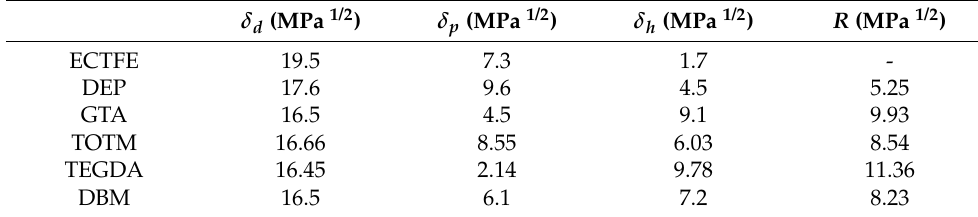
Table 2. Solubility parameters of ECTFE and diluents